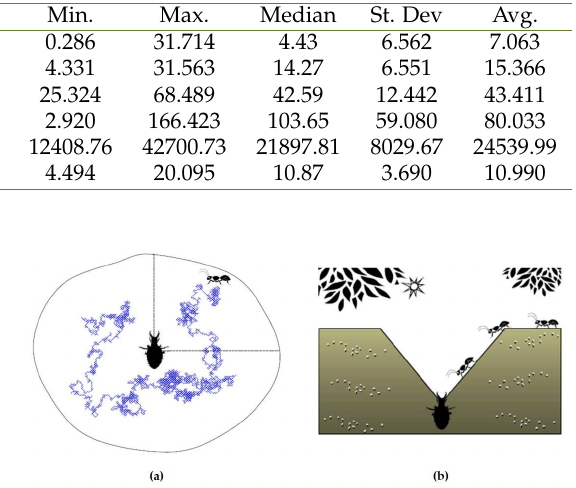
Table 1. The statistical values of the input and output variables